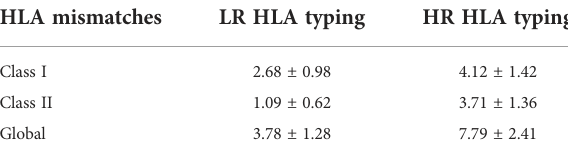
TABLE 2 Mean number of HLA mismatches according to LR HLA typing (A, B, and DRB1) and HR complete HLA typing (A, B, C, DRB1, DQA/B, and